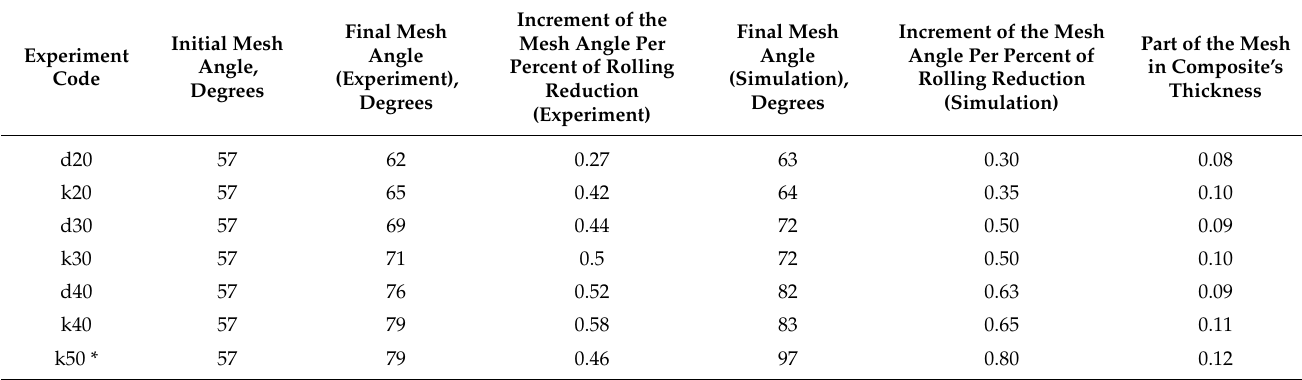
Table 3. Measured parameters of the mesh changes during the roll bonding: the mesh angle and the part of the mesh in the composite’s thickness occupied with reinforcing mesh after experimental rolling.